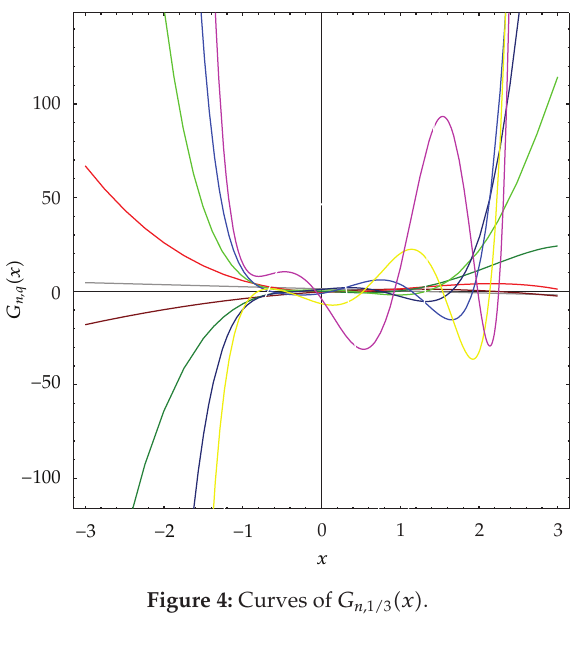
Figure 4: Curves of G n, 1 / 3 (cid:2) x (cid:3) .